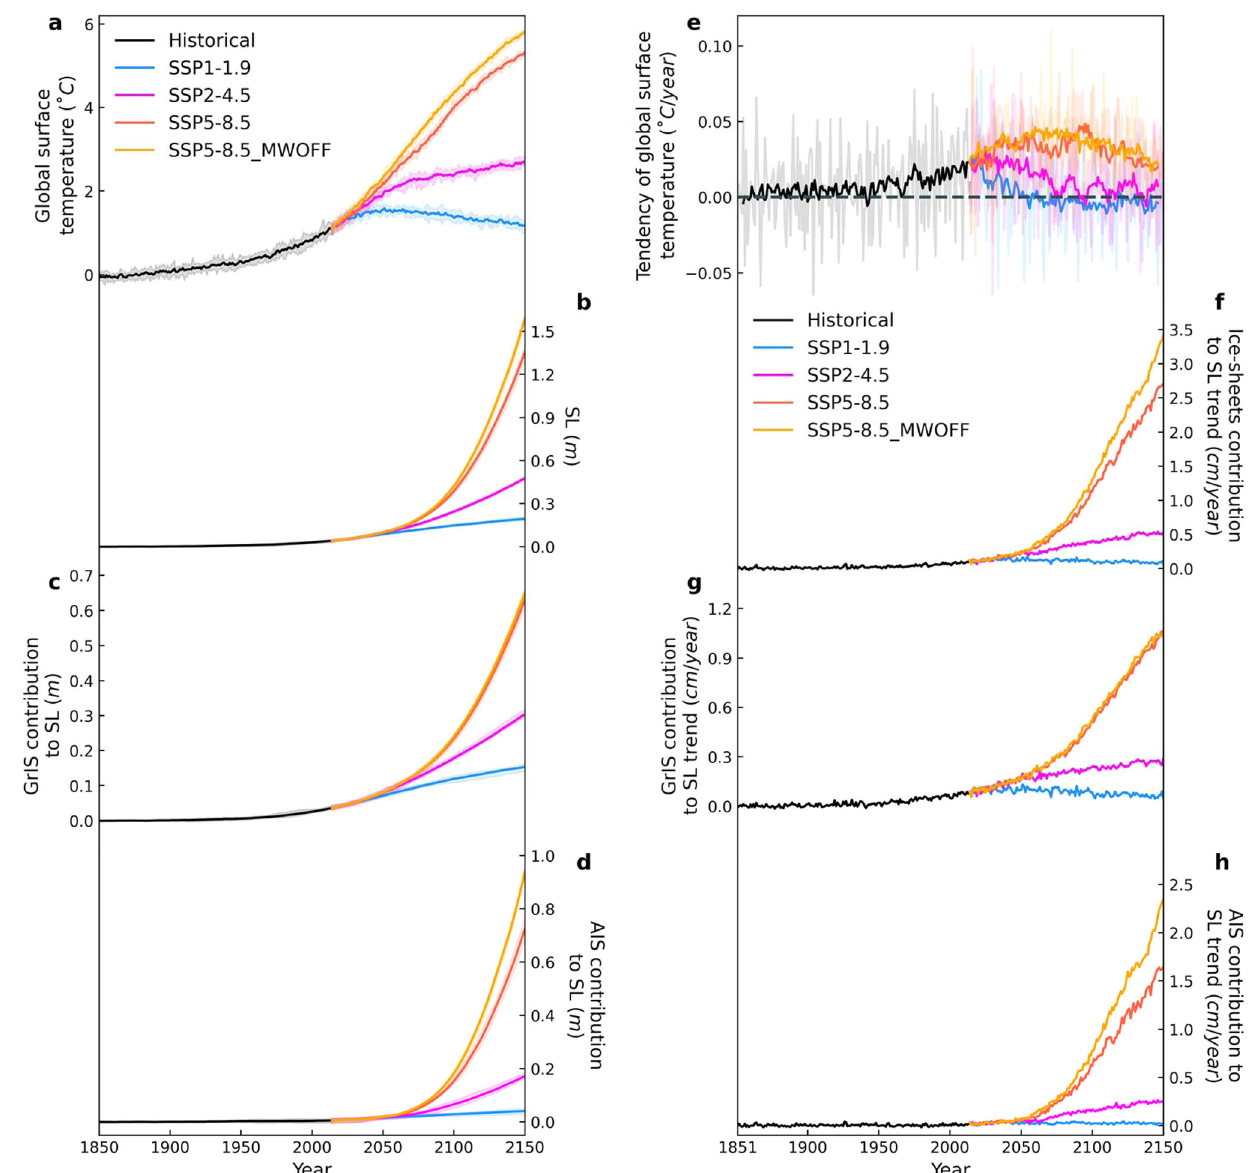
Fig. 2 | Global surface temperature and sea-level (SL) projections, and their tendencies. a – d Annual anomalies (relative to the 1850 – 1900 CE mean) of ( a ) the globalsurfacetemperature,( b )SL,and( c )SLcontributionsfromtheGreenlandice- sheet (GrIS) and ( d ) Antarctic ice-sheet (AIS). e – h are the respective time deriva- tives of a – d (change per year). Solid lines of a – d indicate the ensemble mean and